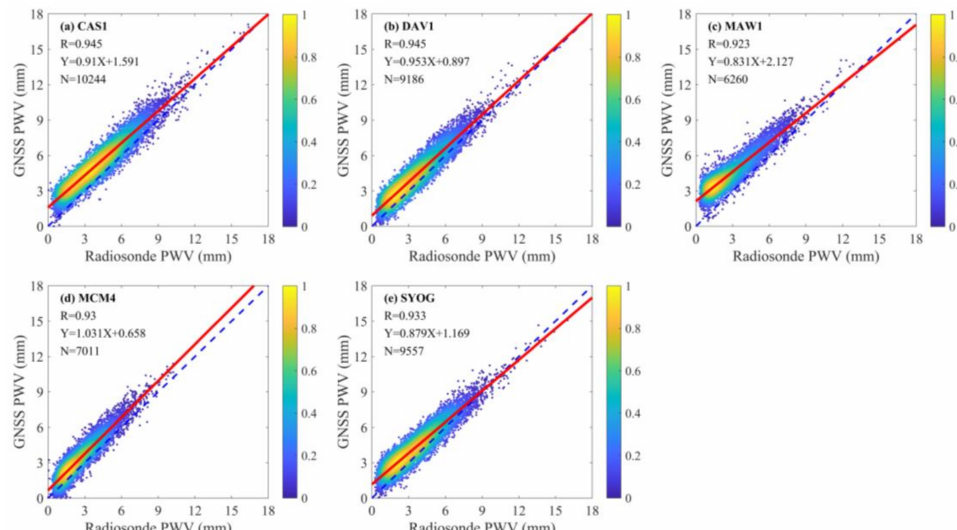
Figure 4. Relative number density plots for PWV from radiosondes and GNSS at the five collocated sites during 2001–2018: